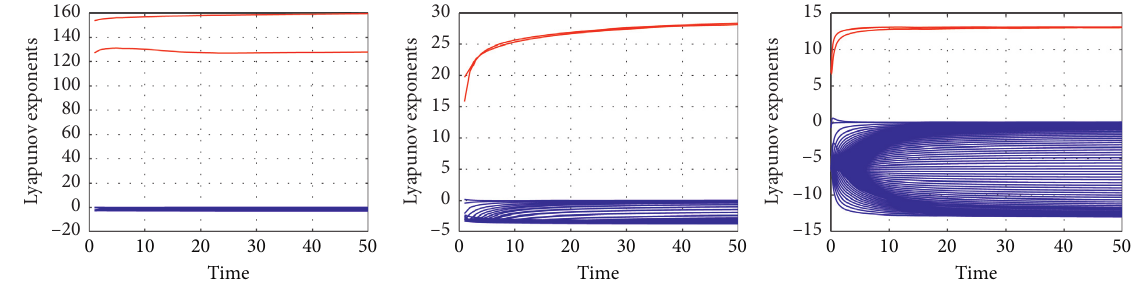
Figure 20: Lyapunov exponents at a � 0 . 125 and τ � 15 for q � 0 . 5, q � 0 . 75, and q � 1,